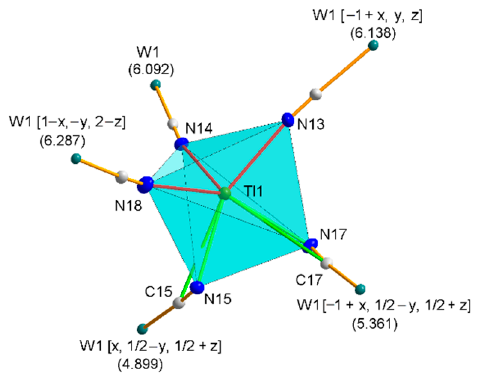
Figure 5. The geometry of the coordination environment of the thallium cation in compound 2 , along with the metallic environment. W-Tl distances in angstroms are given in parentheses. The “side-on” type bridging interactions are marked in green, and the “end-on” type in red.